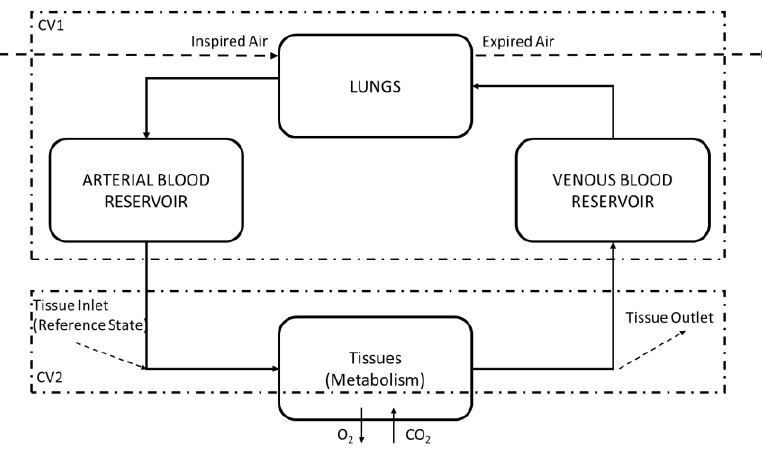
Figure 2. Control volume used by Albuquerque et al., modified from [6].